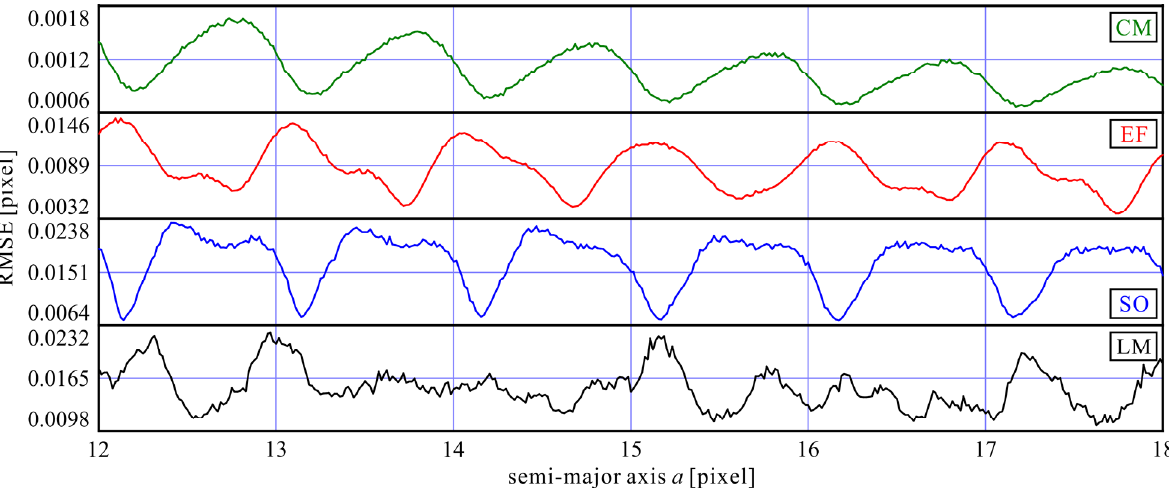
Figure 6. RMSE of the center location measurement of an ellipse (12 pixels  a  18 pixels, f = 0.50,  = of the radius r from 12 to 18 pixels. We guessed that the measurement accuracy of the center location of an ellipse by CM and EF might oscillate in an approximately 0.5 pixel cycle in semi-minor axis b when  = 0.0º.